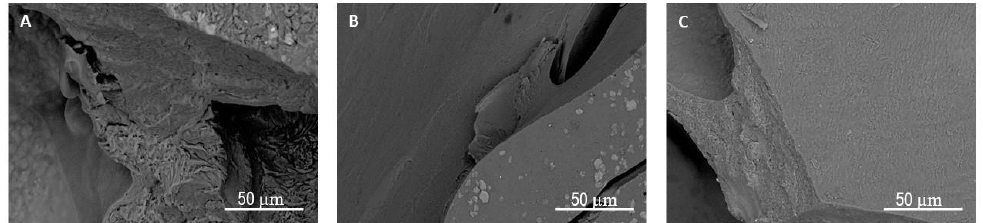
Figure 6. Cross sections of the dried hydrogels with the CA cross-linking agent at the concentrations of ( A ) 5% w/w; ( B ) 10% w/w and ( C ) 15% w/w.